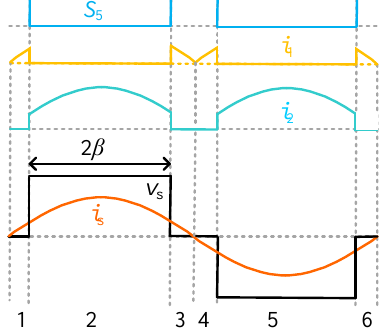
Figure 2. Typical waveforms of proposed receiver. S 5 , gate drive signal (blue line); i 1 , current flowing through MOSFET (yellow line); i 2 , current flowing through D 5 (light green line); i s , secondary resonant current (orange line); v s , secondary resonant voltage (black line).